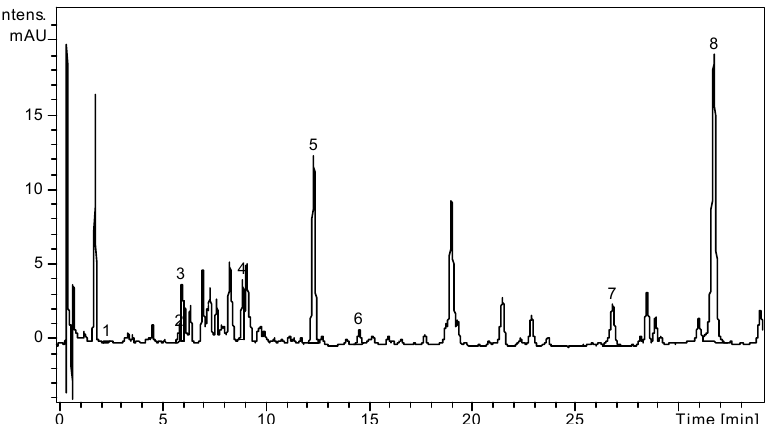
Figure 3. HPLC chromatogram of hydrolysed sample of A. schoenoprasum L . subsp. schoenoprasum (A3